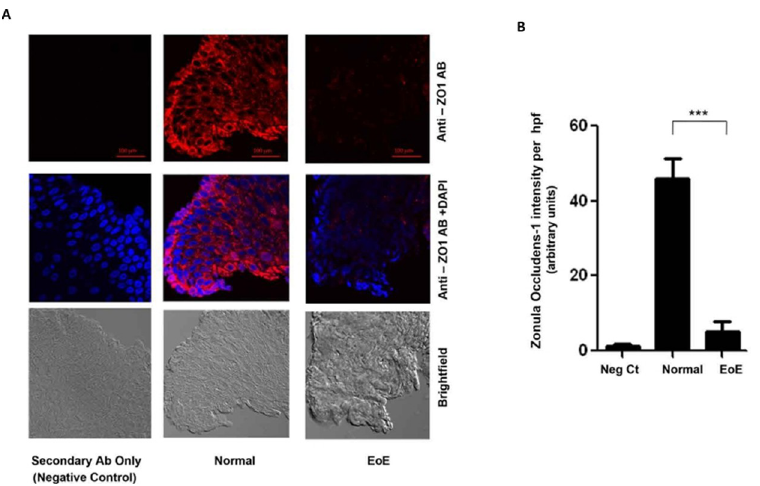
Fig 2. Representative photomicrograph and quantitation of IF analysis of control and EoE esophageal tissue: Photomicrograph of: A. Zonula Occludens-1 and B. E-cadherin. ��� P < 0.001.